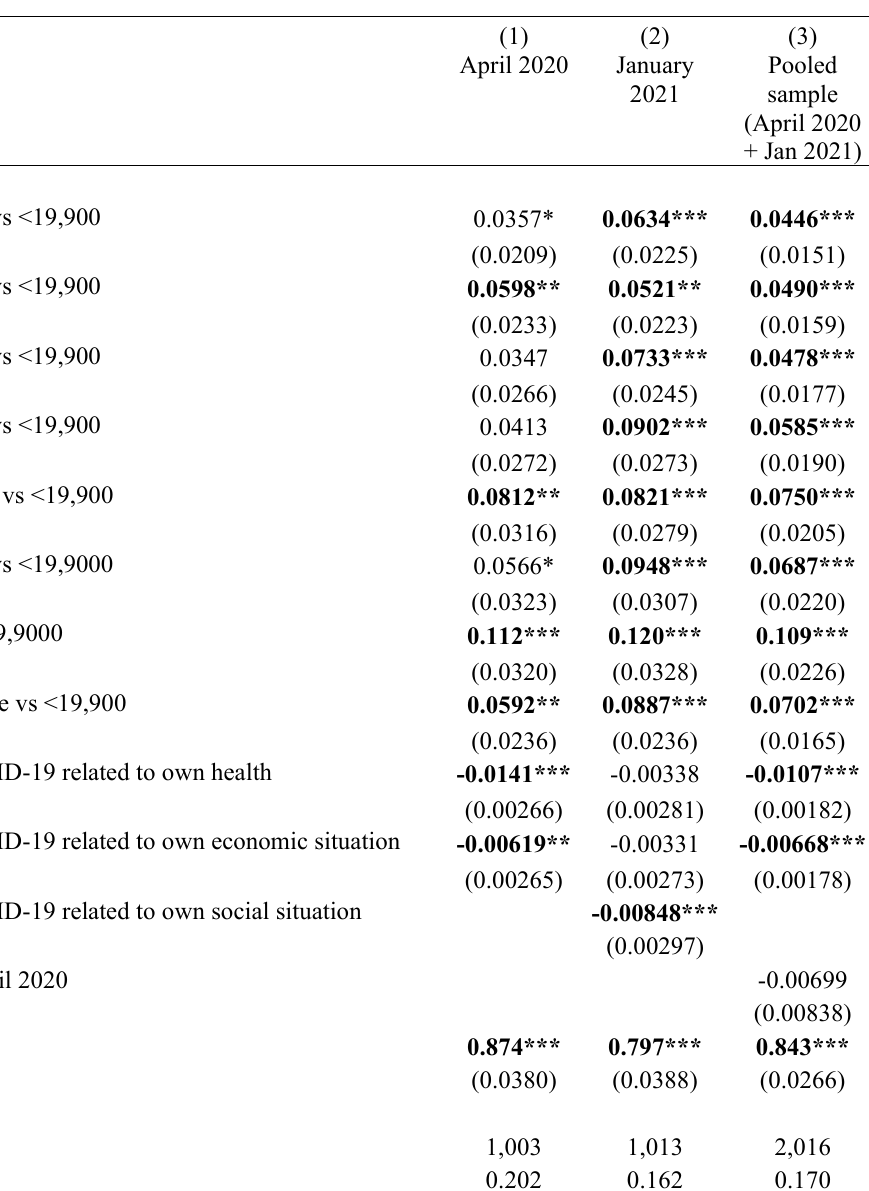
Table A1: Regressions of HRQoL on EQ-5D-5L (continued)